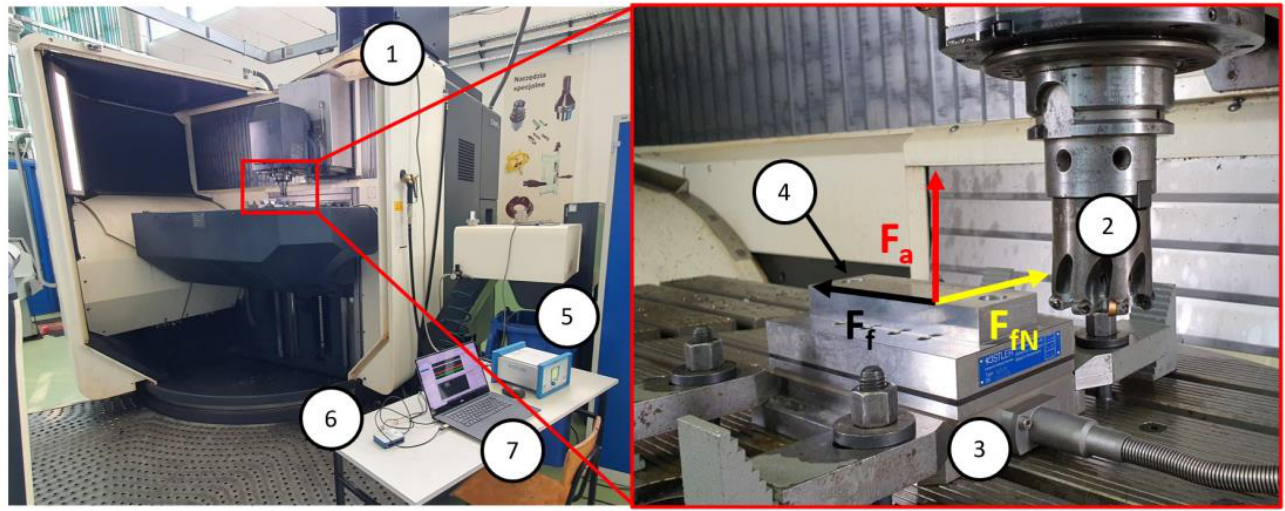
Figure 5. View of the test stand and machine workspace: (1) machine tool; (2) cutting tool; (3) dynamometer; (4) test sample; (5) charge amplifier; (6) A/C converter; (7) computer.